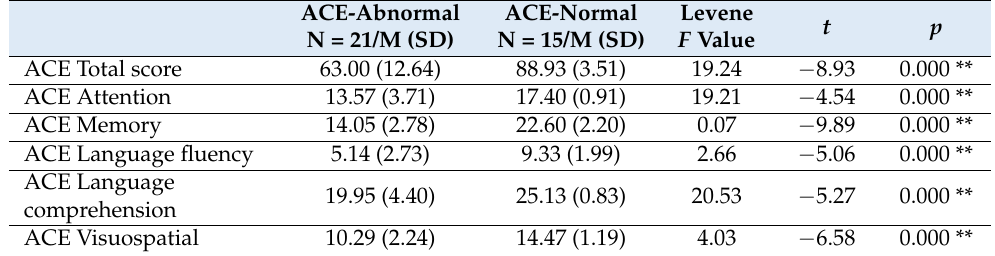
Table 1. Independent t -test of ACE-III total score and subtests between ACE groups.